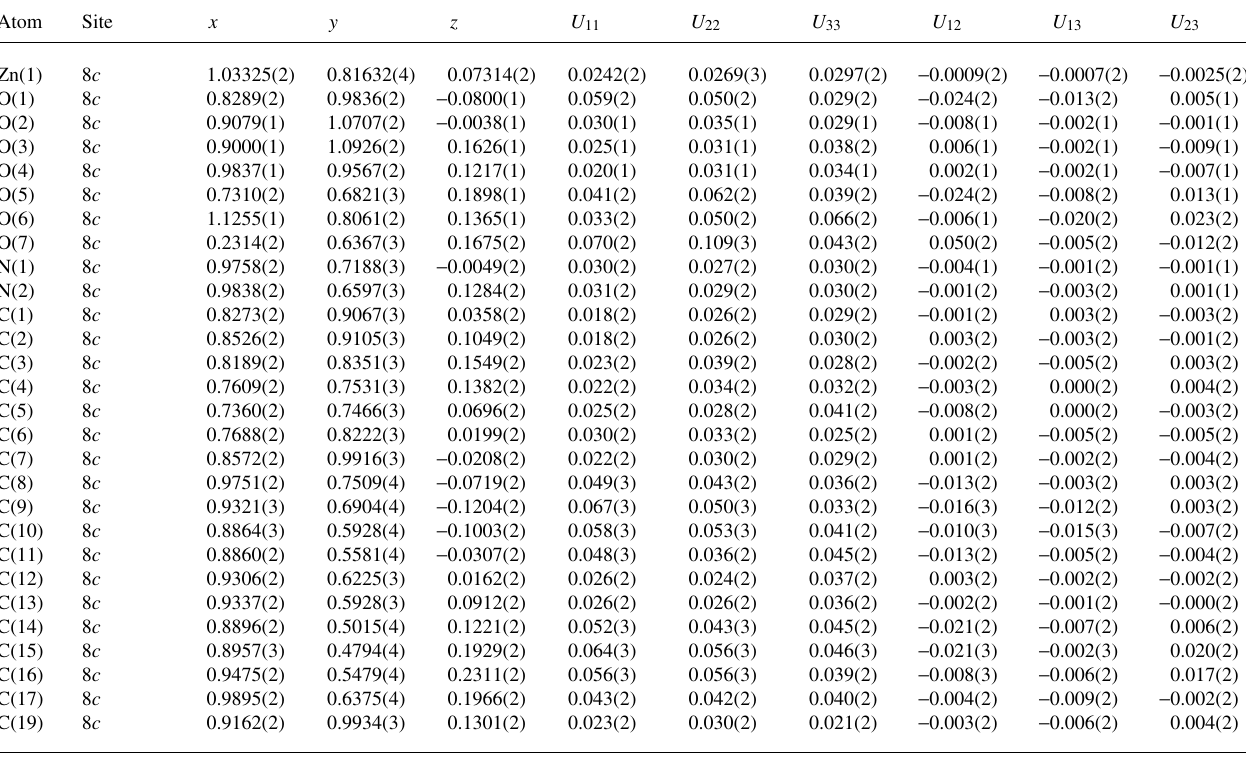
Table 3. Atomic coordinates and displacement parameters (in Å 2 )